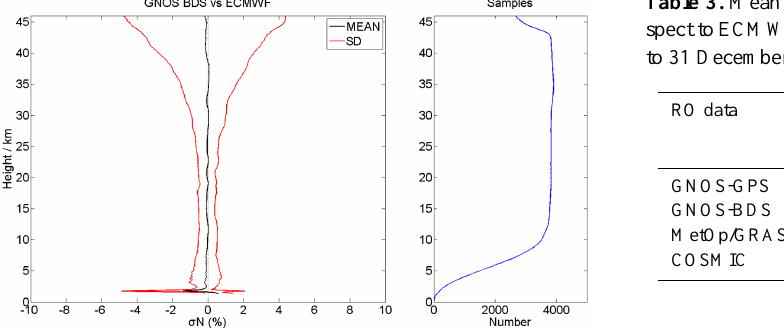
Table 3. Mean bias and standard deviation of refractivity with